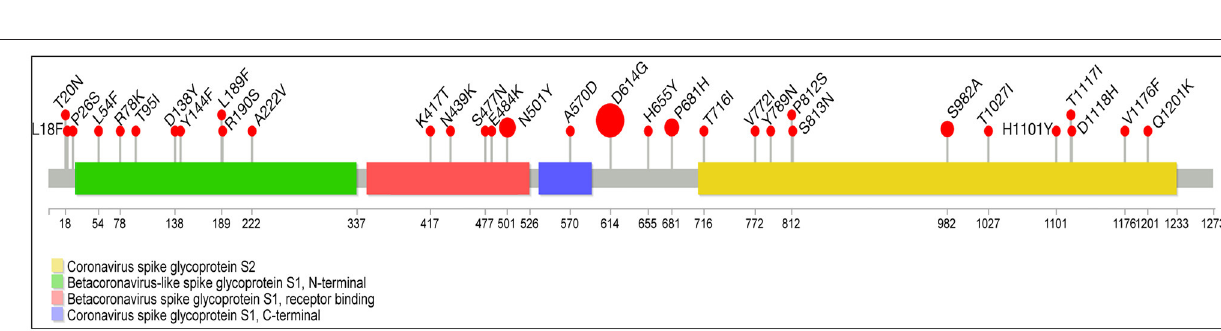
FIGURE 3 | Genetic distance for the SARS-CoV-2 genome lineages. Sequences are colored by Pango lineage as shown in the legend. Reference sequence: NC_045512.2. Lineage “B.1.1” refers to haplotype B: B.1.1.351 and B.1.1.374. “B other” refers to B.1.177.53, B.1.177.75, B.1.177, B.1.258.14, B.1.258.17, and B.1.160. The size of the circle is related to the number of samples.